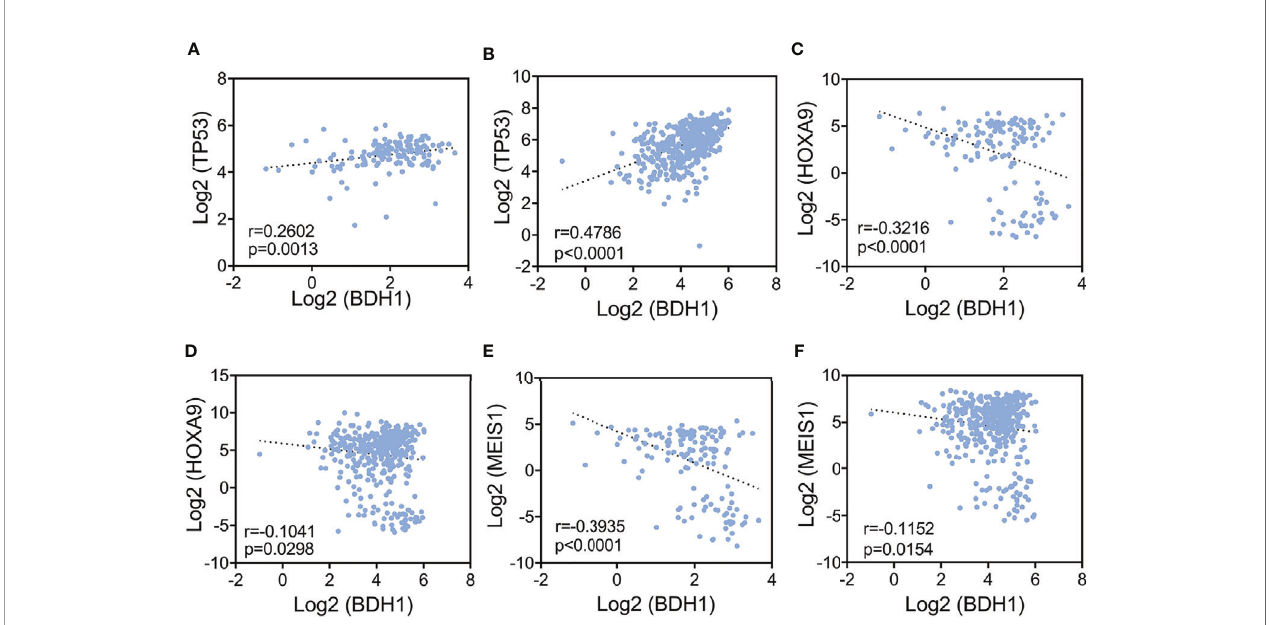
FIGURE 3 | The expression level of BDH1 is signi fi cantly correlated with that of HOXA9 , MEIS1 , and TP53 in AML. Results of the pair-wise inter-correlation analysis of gene expression levels of BDH1 and TP53 , HOXA9 , MEIS1 based on TCGA-LAML database (A, C, E) and BEATAML database (B, D, F) are